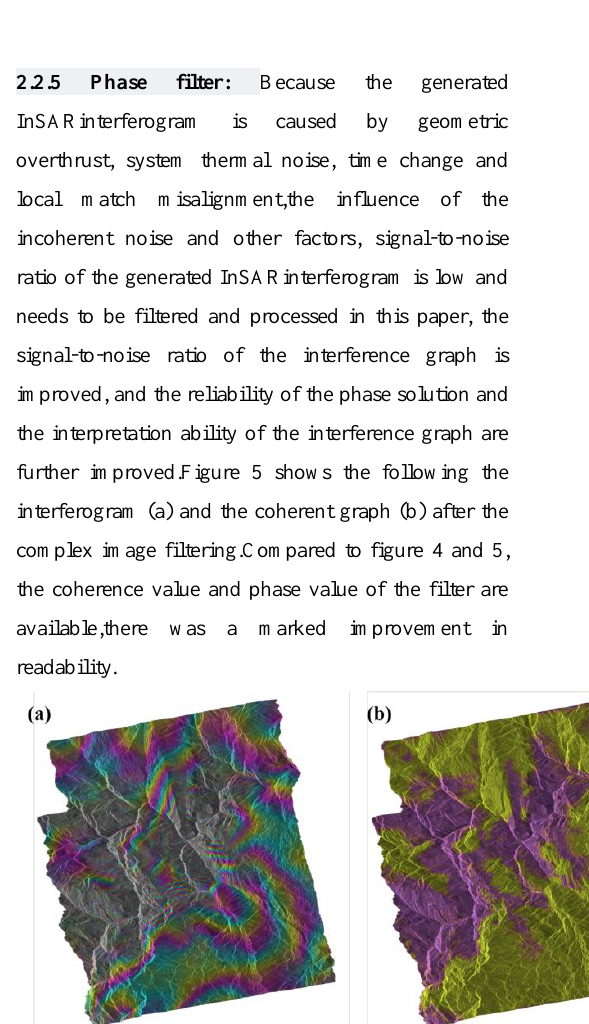
InSAR is directly affected by the quality of the phase solution.Figure 6 is the least used the interferometric phase of the phase unwrapping is carried